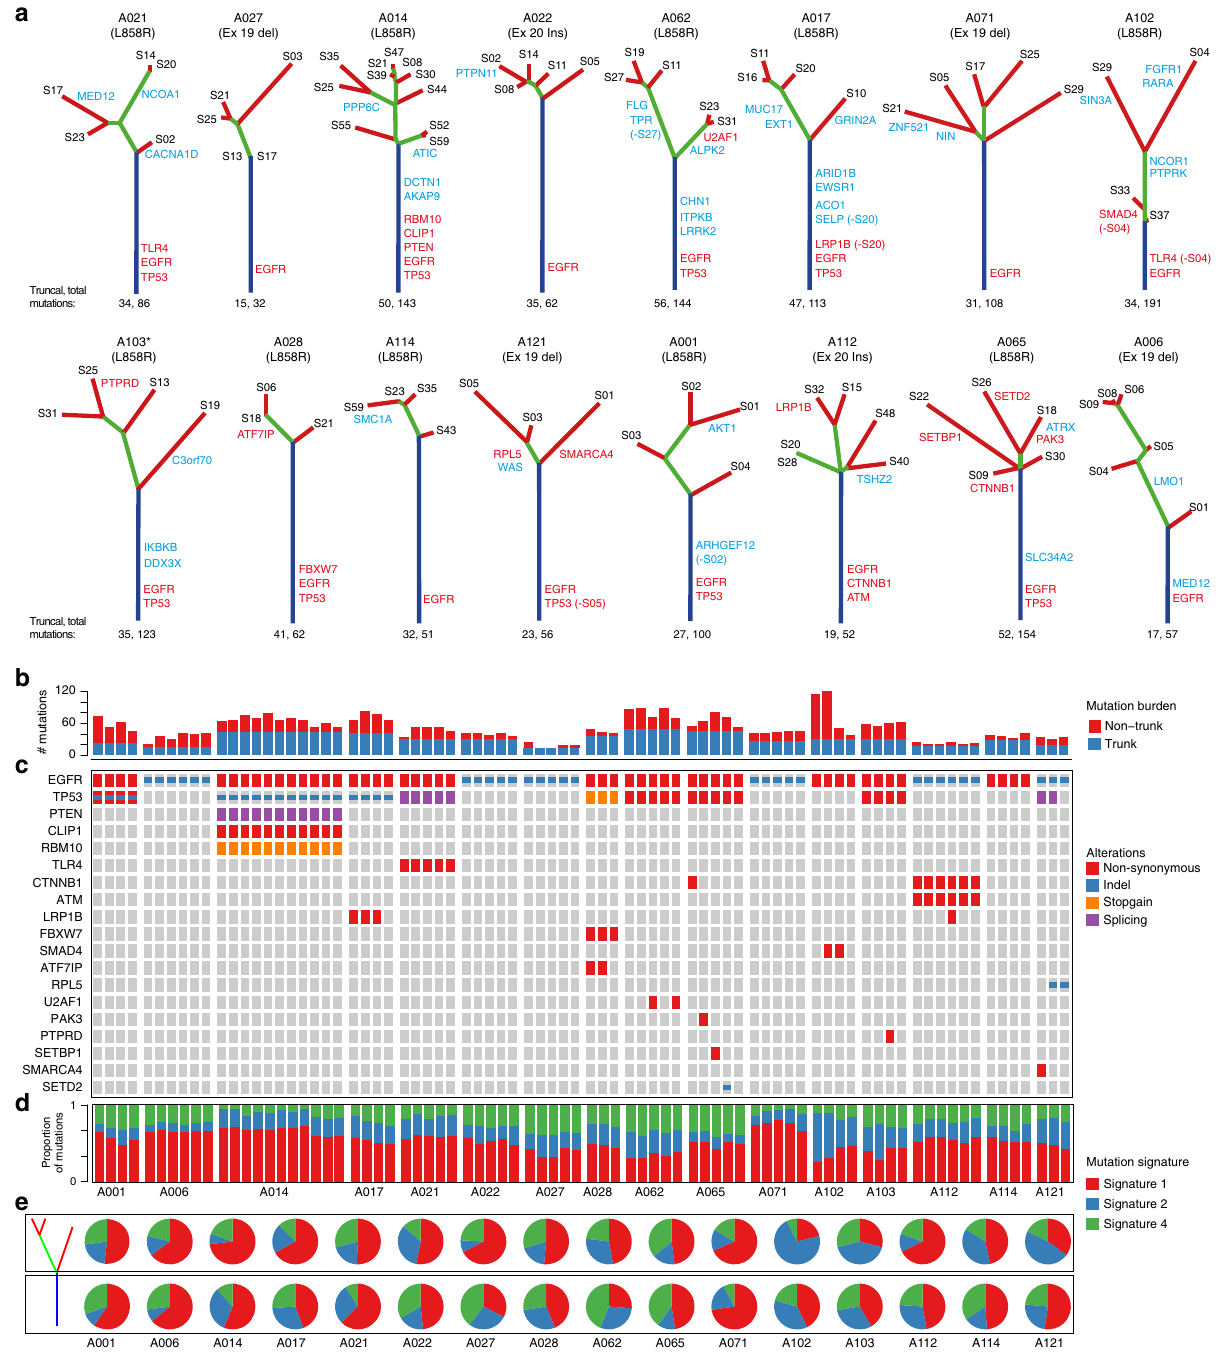
Fig. 1 Landscape of clonal and subclonal mutations in Asian EGFR -mutant tumors. a Phylogenetic trees generated for the 16 Asian EGFR -mutant LUADs. Trunks, branches and tips are depicted in blue, green, and red, respectively, while non-silent mutations carrying LUAD speci fi c drivers are in red and other cancer drivers are in blue (Methods section). All patients are never-smokers except A103 (marked *) who was a light ex-smoker. Truncal mutation burden followed by total mutation burden for all sectors is indicated below the trees. b Bar plot representing truncal and non-truncal mutation burden per sector. c Oncoprint heatmap for mutations in LUAD drivers depicting the presence (see color legend) or absence (gray box) and type of non-silent mutation. d Proportions of the three mutation signatures identi fi ed for each sector. Signature numbers are according to the COSMIC nomenclature. e Pie charts representing contribution of the three mutation signatures in early (trunk) and late (branch/private) mutations signature-1 36,37 dominated the mutational landscape of these 16 any signature between the early and late events (signature-1: P = EGFR -mutant patients including the light ex-smoker A103 0.43; signature-2: P = 0.62; signature-4: P = 0.08, paired t -test). (Fig. 1d). The distribution of signatures between early (trunk) and However, 4 of 16 patients (A102, A103, A114, and A121) late events (branch/private) was heterogeneous across patients demonstrated relatively higher contribution of APOBEC activity (Fig. 1e) and collectively we did not fi nd signi fi cant change for (signature-2) in late subclonal events (Fig. 1e). Of note, marked NATURE COMMUNICATIONS | (2018)